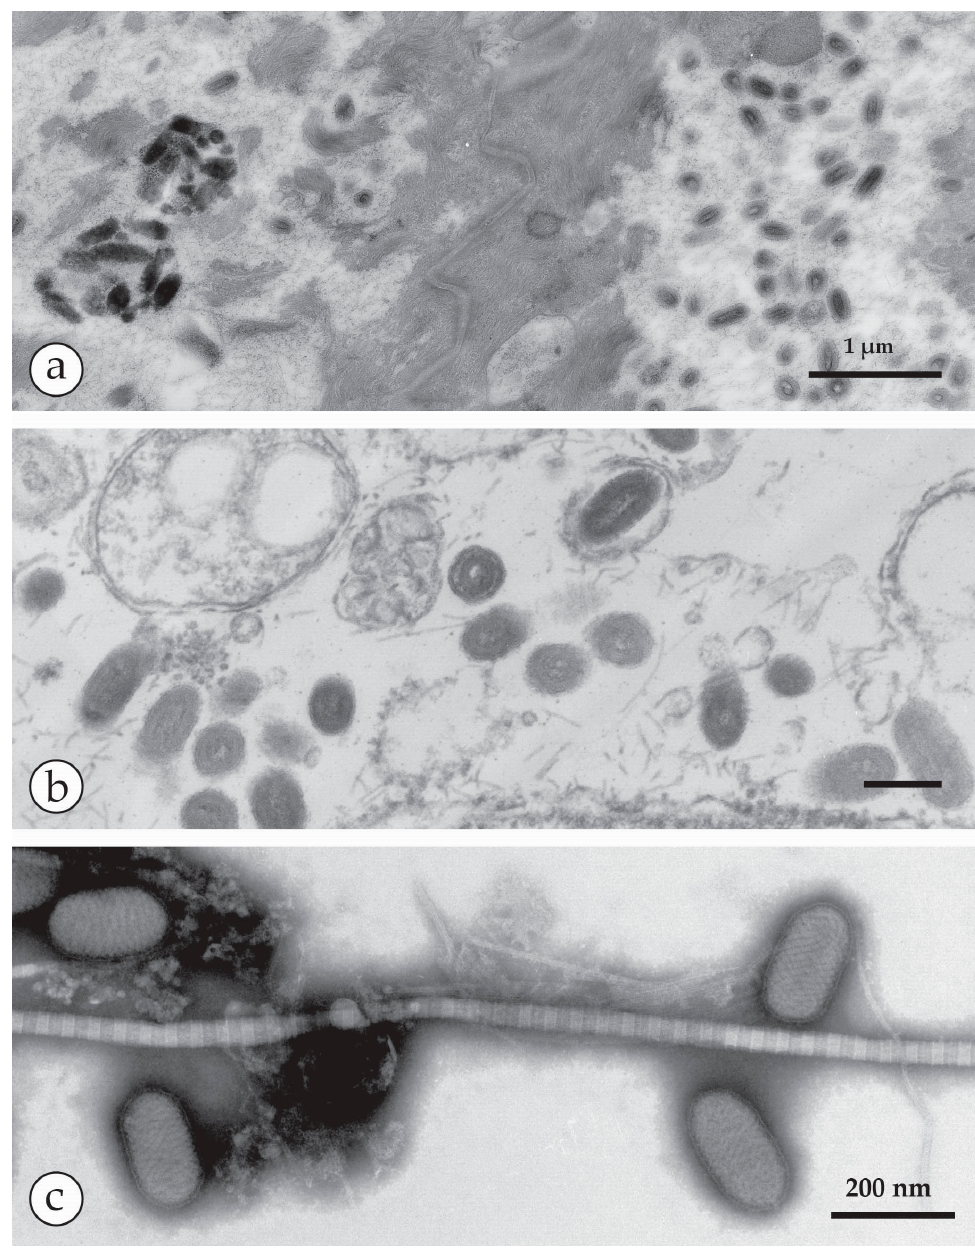
Figure 8. DEM of another human PPV infection (sample courtesy of Prof. Friedrich A. Bahmer, Bremen): ( a ) TS-DEM of a biopsy of a papule showing numerous particulate objects: on the right, PPV particles can be seen while the numerous electron-dense structures on the left are melanosomes–normal skin constituents Bar in ( a ) = 1 µm. In the middle are desmosomes connecting cells in the prickle cell layer. ( b ) TS-DEM at an intermediate magnification reveals the oval shapes typical of PPV seen in a damaged cell. ( c ) PPV particles are seen also by NS-DEM after grinding parts of the biopsy in distilled water, followed by low speed clarifying centrifugation. Amongst some detritus and a long collagen fibre, the ovoid PPV particles show long parallel surface threads. Bars in ( b , c ) = 200 nm.